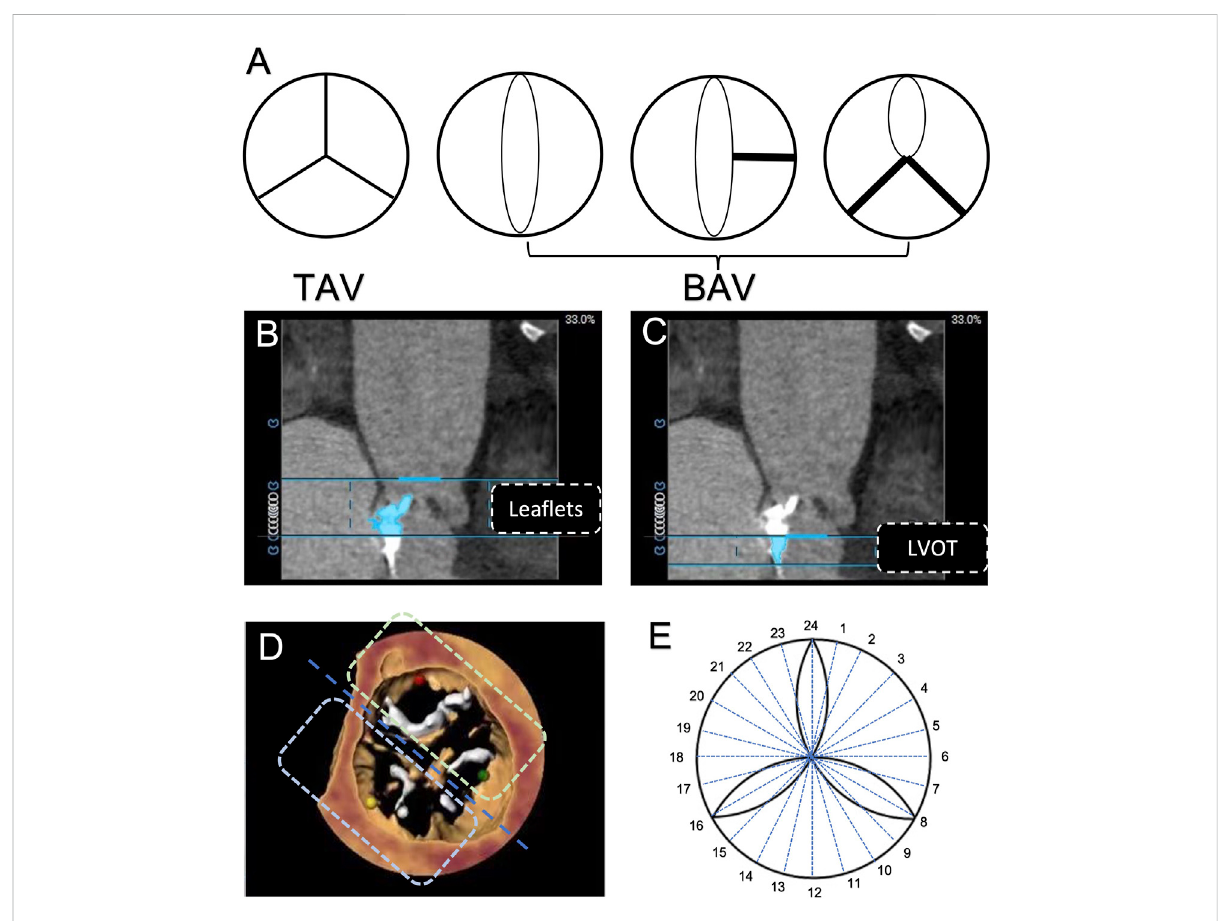
FIGURE 1 Aortic valve phenotype and calci fi cation evaluation based on computerized tomography. (A) Classi fi cation of aortic valve morphology. (B) Region ofthe aortic valve lea fl et. (C) Regionof theleft ventricular out fl owtract. (D) Assessmentof aortic valvecalci fi cation eccentricity by theuse of the ‘ bi-plane method ’ . (E) 24 sectors were divided by every 15 ° to calculate the maximum difference of calci fi cation